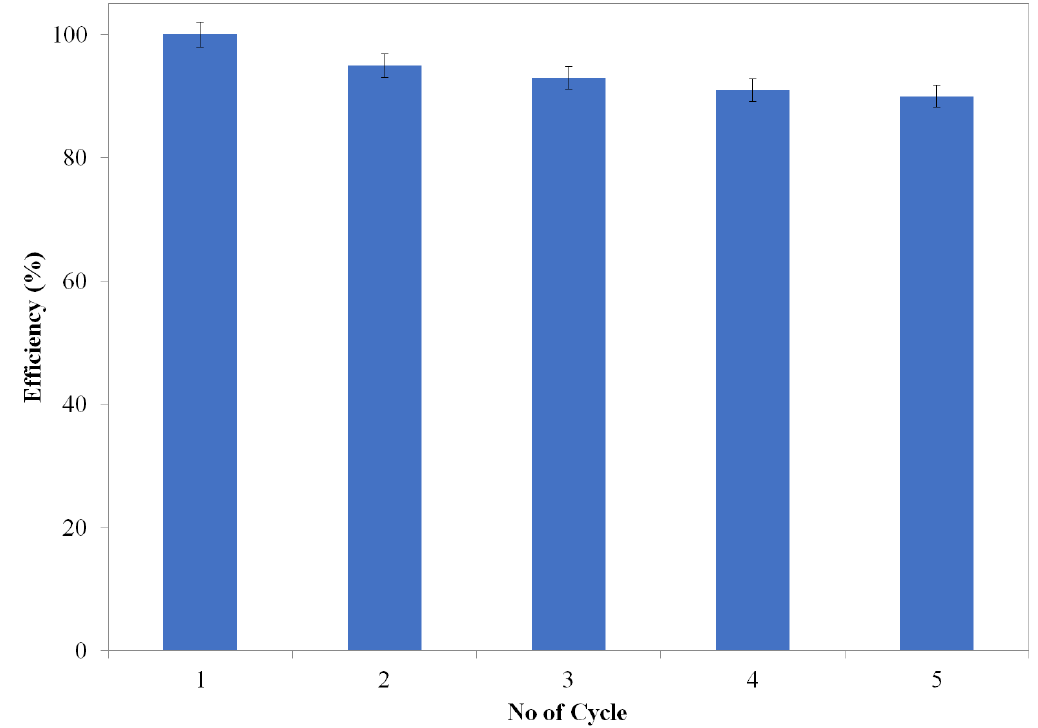
Figure 12. Recycling efficiency of the catalyst Fe 3 O 4 @CS@MS@Ag for the reduction of 4-NP to 4-AP.